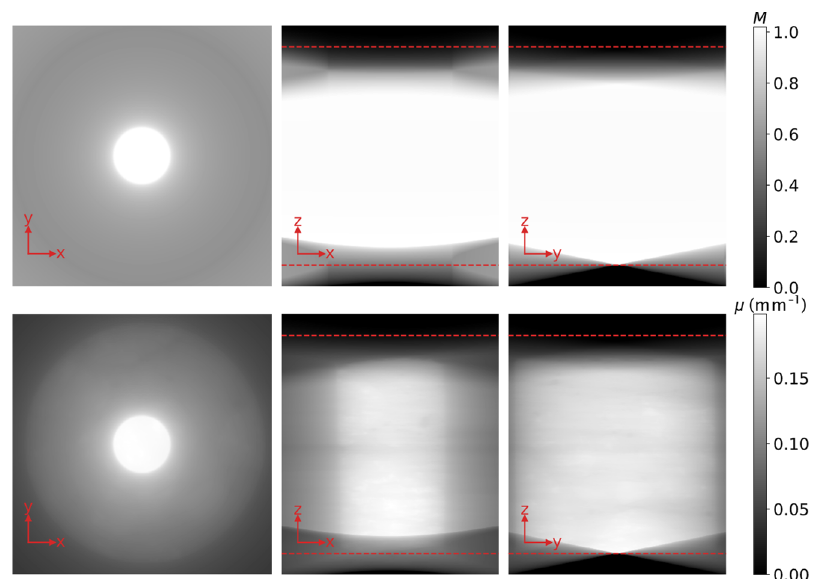
Figure 4. Top row: Orthogonal slices through the model M of the artefacts that arise during the reconstruction; Bottom row: Orthogonal slices through the volume resulting from the back-projection of the unfiltered projections of the concrete rod. The extent of the volume of Figure 1 along the z-axis is indicated by the red dashed lines. Apart from that, the position of the slices shown in either row corresponds precisely to that of the slices in Figure 1.